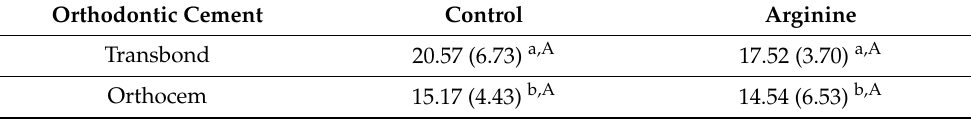
Table 2. Mean (standard deviation) values (MPa) of shear bond strength of the tested materials. Orthodontic Cement